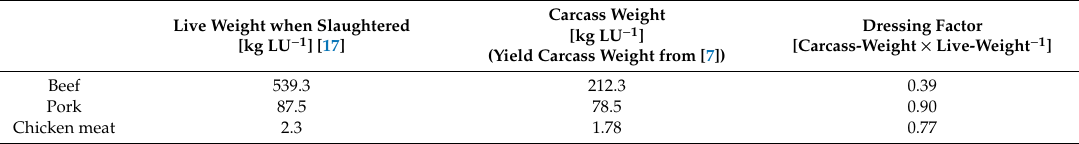
Table 2. Dressing factors for beef, pork and chicken meat calculated for this paper. Source of data: live weight of the Livestock Unit (LU) [17]; carcass weight per Livestock Unit: national average in 2014 from the Food Balance Sheets